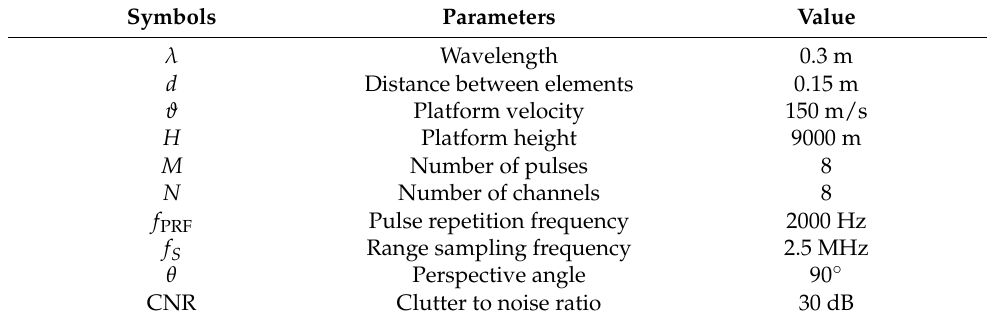
Table 2. Radar system parameters.